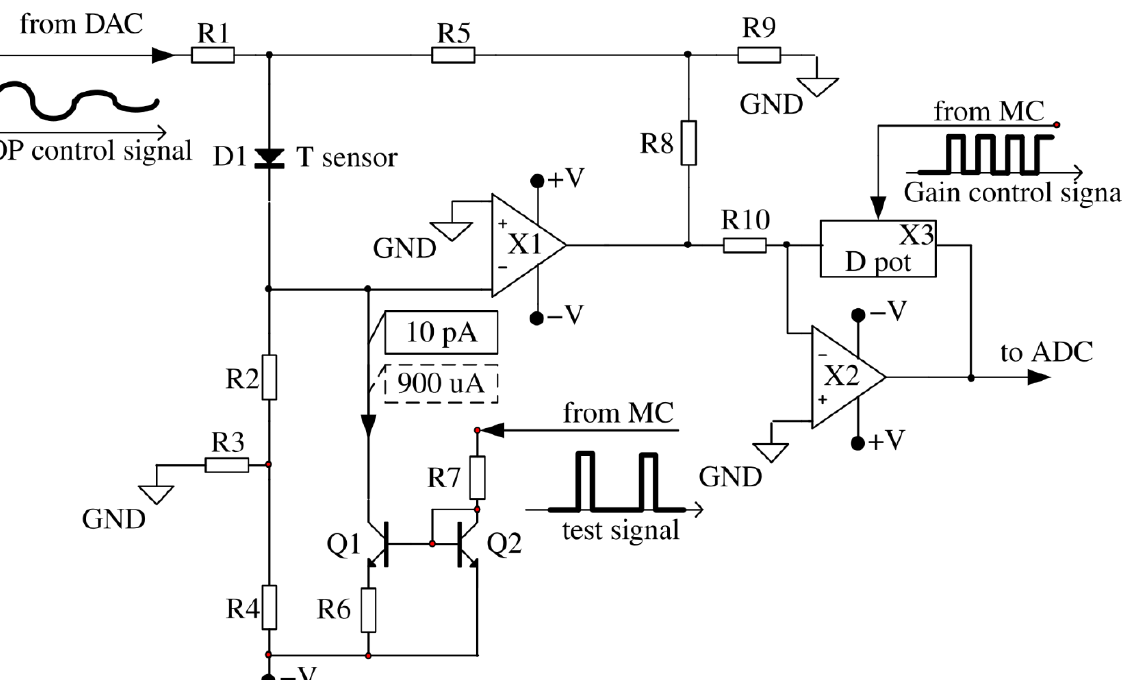
Figure 4. Schematic diagram of the input part of the thermometer structurally located in a separate part, located on the surface of the subject’s body. From the “from MC” inputs to the circuit, a digital signal is sent to regulate the gain of the second amplifying stage and to test the operation of the thermometer. From the “from DAC” input, an analog signal from a digital-to-analog converter (DAC) is applied to the circuit to control the position of the operating point of the first amplifier stage.